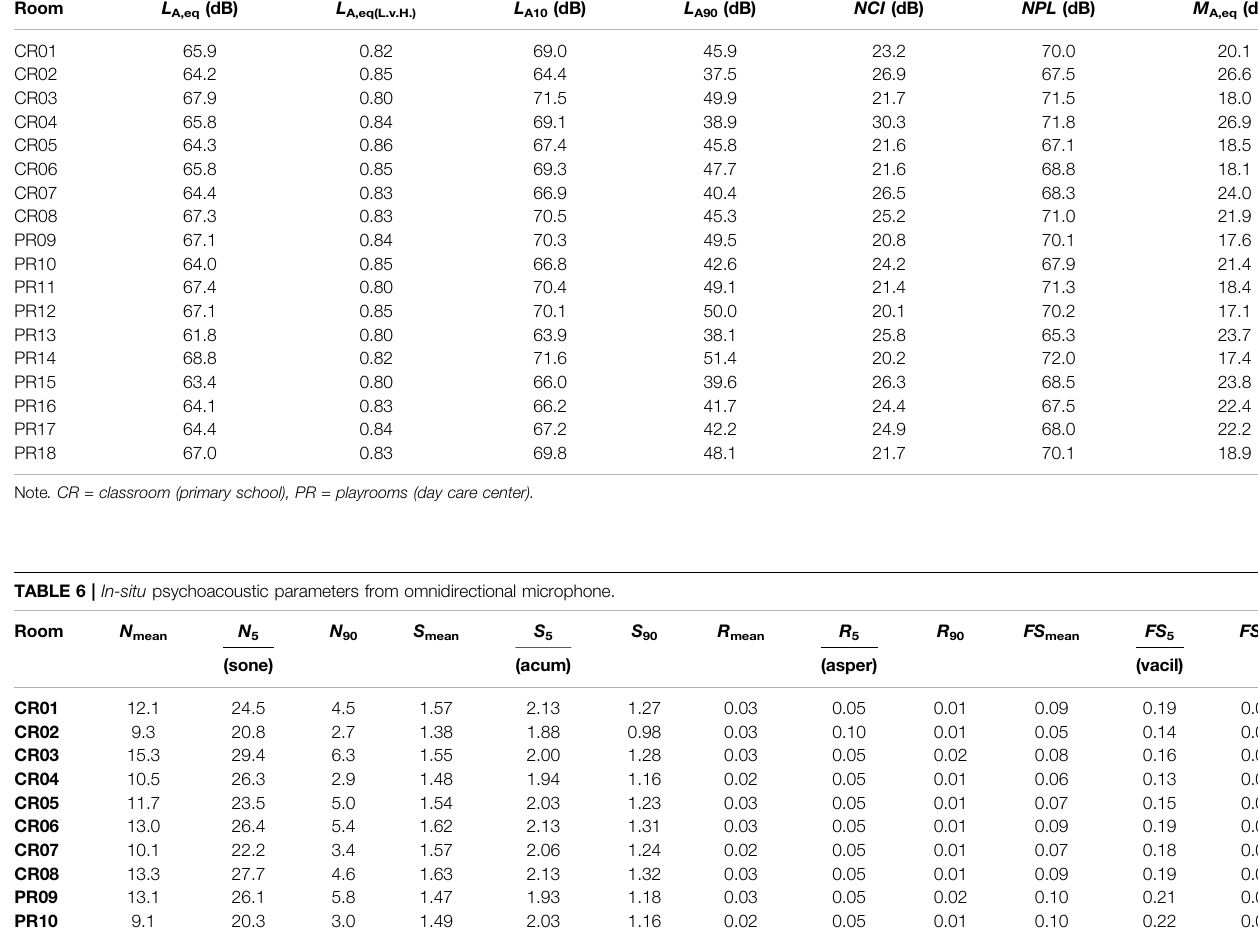
TABLE 5 | In-situ sound pressure level parameters from omnidirectional microphone. Room